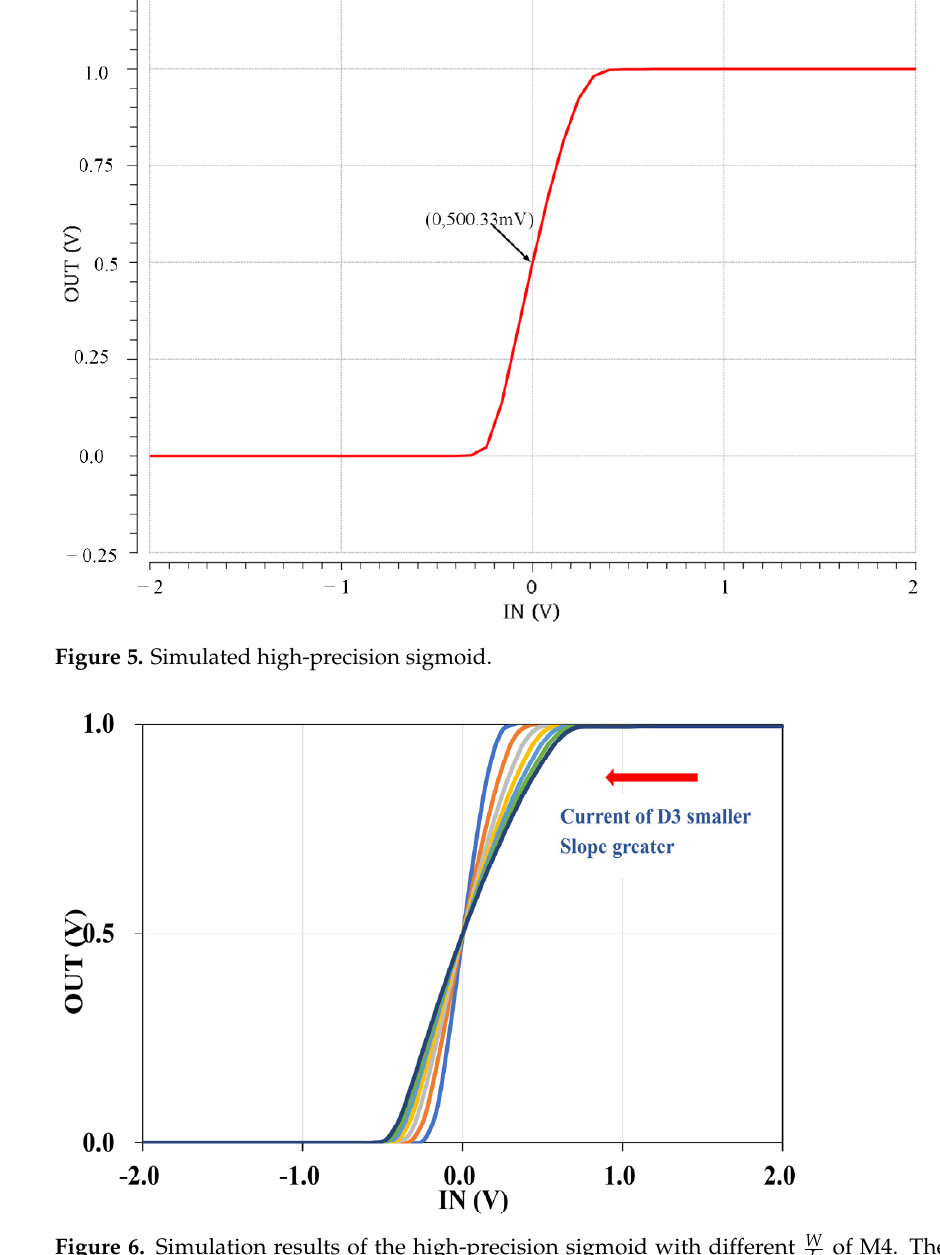
of M4 getting of M4 getting smaller. L of M4 getting smaller. (cid:3013) (cid:3013)